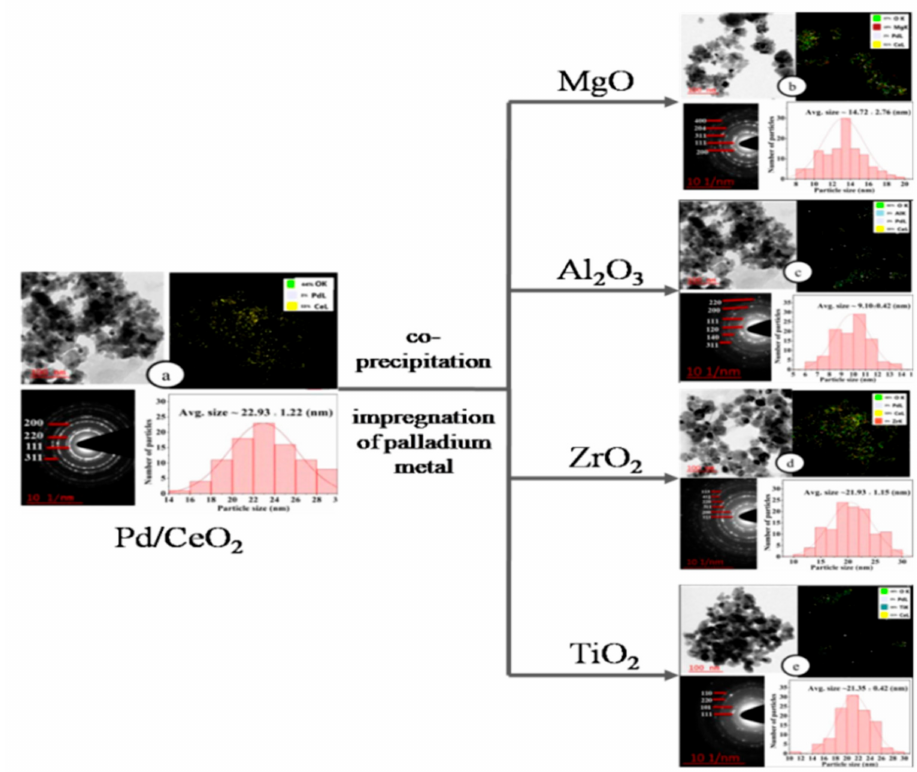
Figure 7. TEM micrograph of all the catalysts: ( a ) Pd/CeO 2 , ( b ) Pd/MgO-CeO 2 , ( c ) Pd/Al 2 O 3 -CeO 2 , ( d ) Pd/ZrO 2 -CeO 2 , ( e ) Pd/TiO 2 -CeO 2